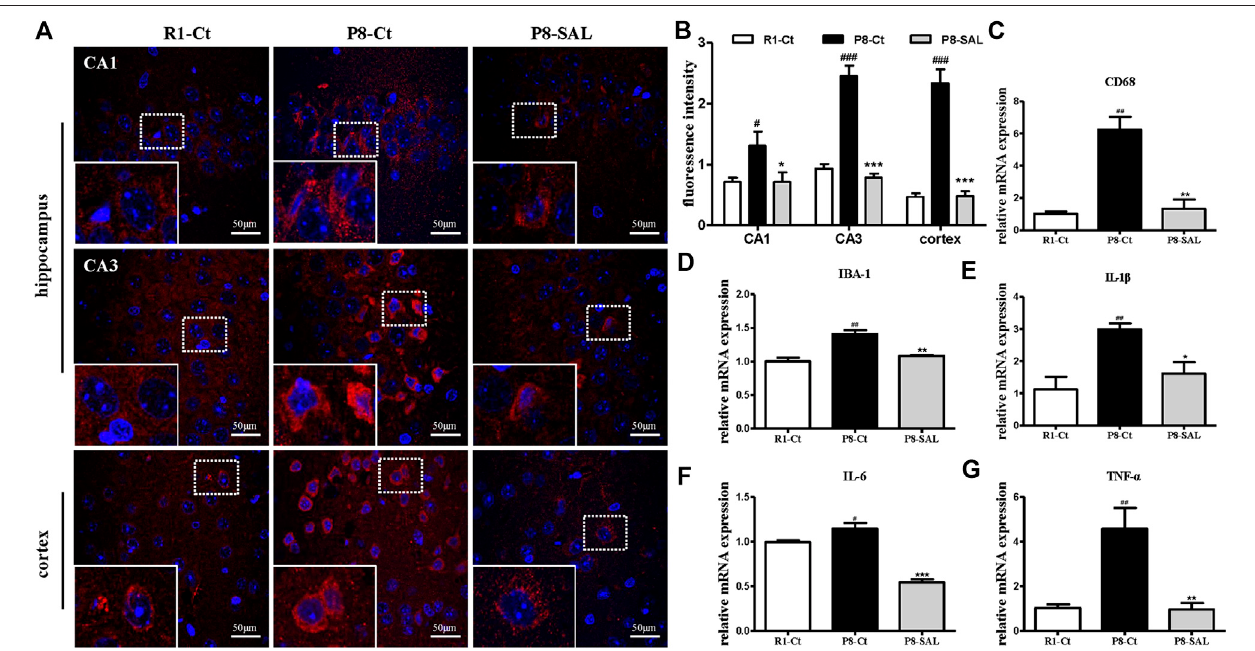
FIGURE4 | Effect of SAL on neuroin fl ammation in SAMP8 mice. (A,B) Representative images and quanti fi cation of immuno fl uorescence analysis using antibodies against CD68 (red) and DAPI staining (blue) in the hippocampus (CA1 and CA3 regions) and cortex (magni fi cation × 400). The dotted box presents an enlarged image of the inset. The mRNA levels of (C) CD68, (D) IBA-1, (E) IL-1 β , (F) IL-6 and (G) TNF- α ,were determined by qPCR. All data are shown as the mean ± SEM ( n (cid:2) 3 for each group). # p < 0.05, and ## p < 0.01 versus the R1-Ct group and * p < 0.05, ** p < 0.01, and *** p < 0.001 versus the P8-Ct group.